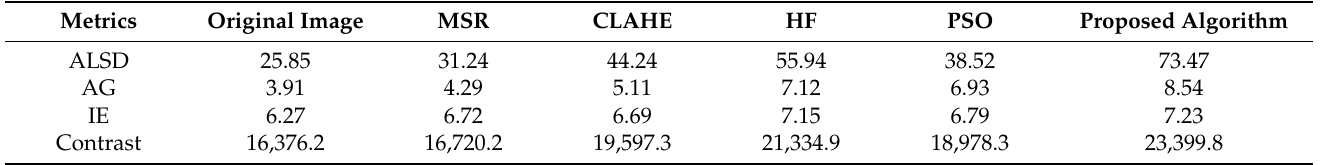
Table 1. Comparison of corridor image enhancement